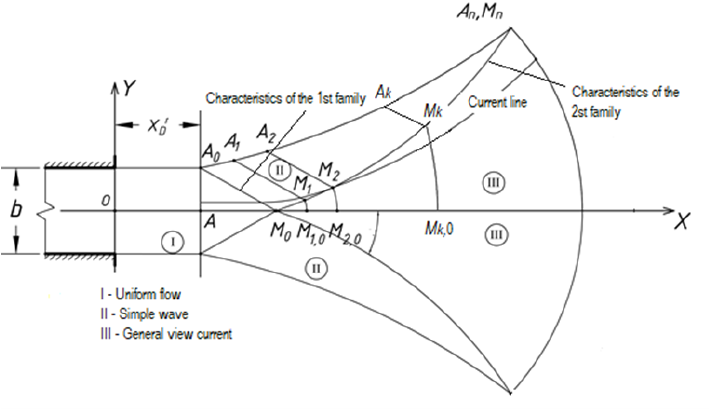
Figure 4. Flow spread